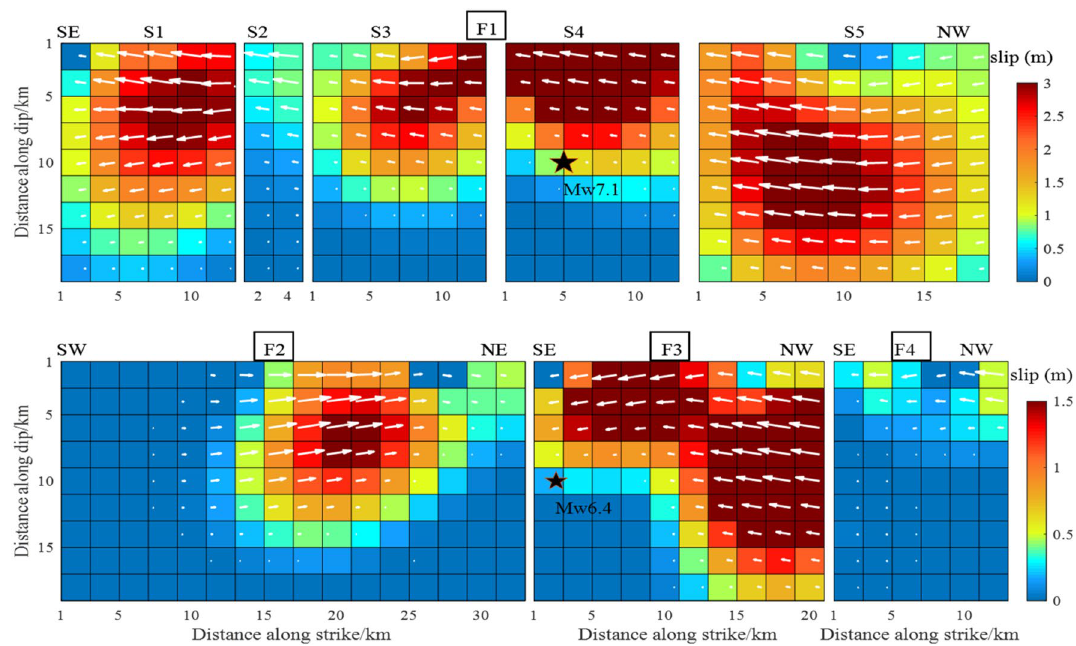
Figure 10. The slip distribution of the Mw 6.4 foreshock and the Mw 7.1 main shock from inversion of T71-D coseismic